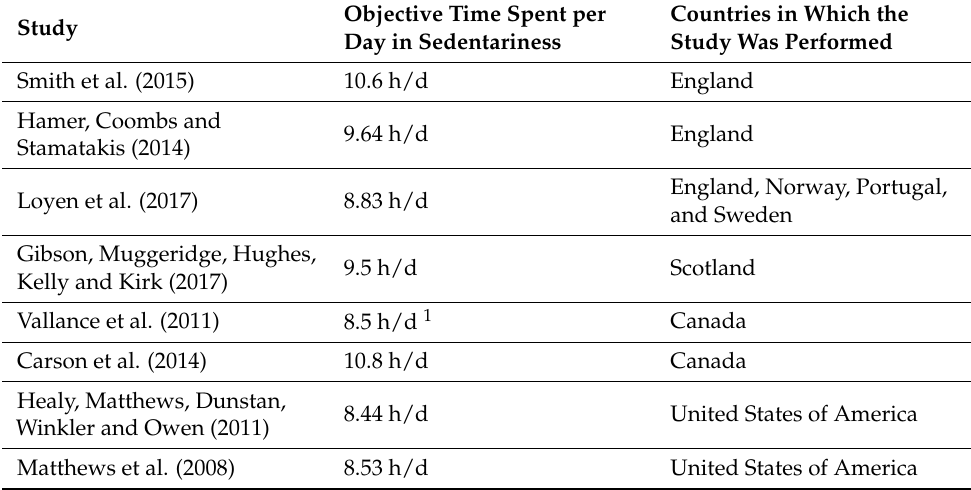
Table 1. Objective time spent seated (using accelerometers and/or